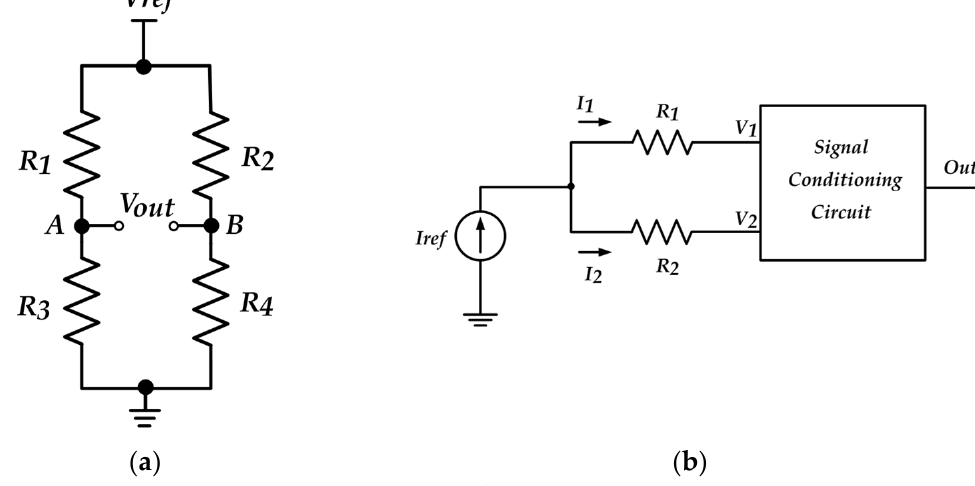
Figure 5. ( a ) Voltage-mode Wheatstone bridge and ( b ) current mode Wheatstone bridge [9].